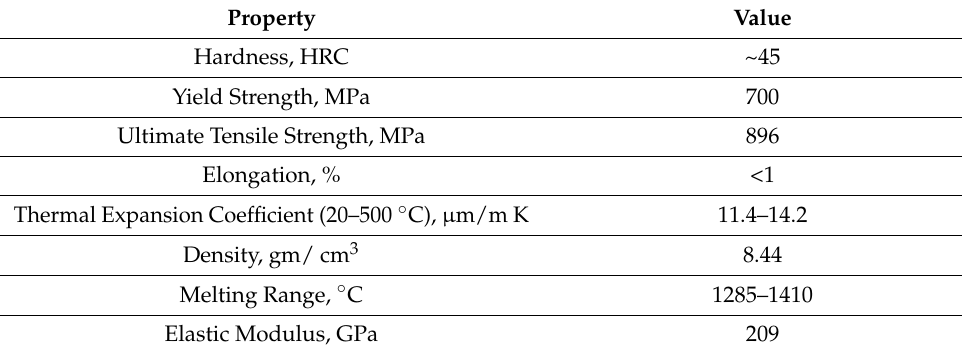
Table 2. Properties of Stellite 6 [35].